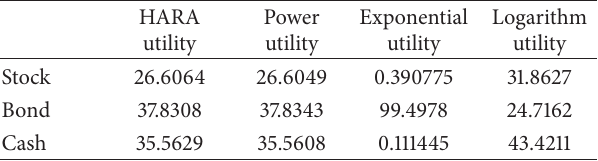
Table 1: The optimal policy with liability and affine interest rate.